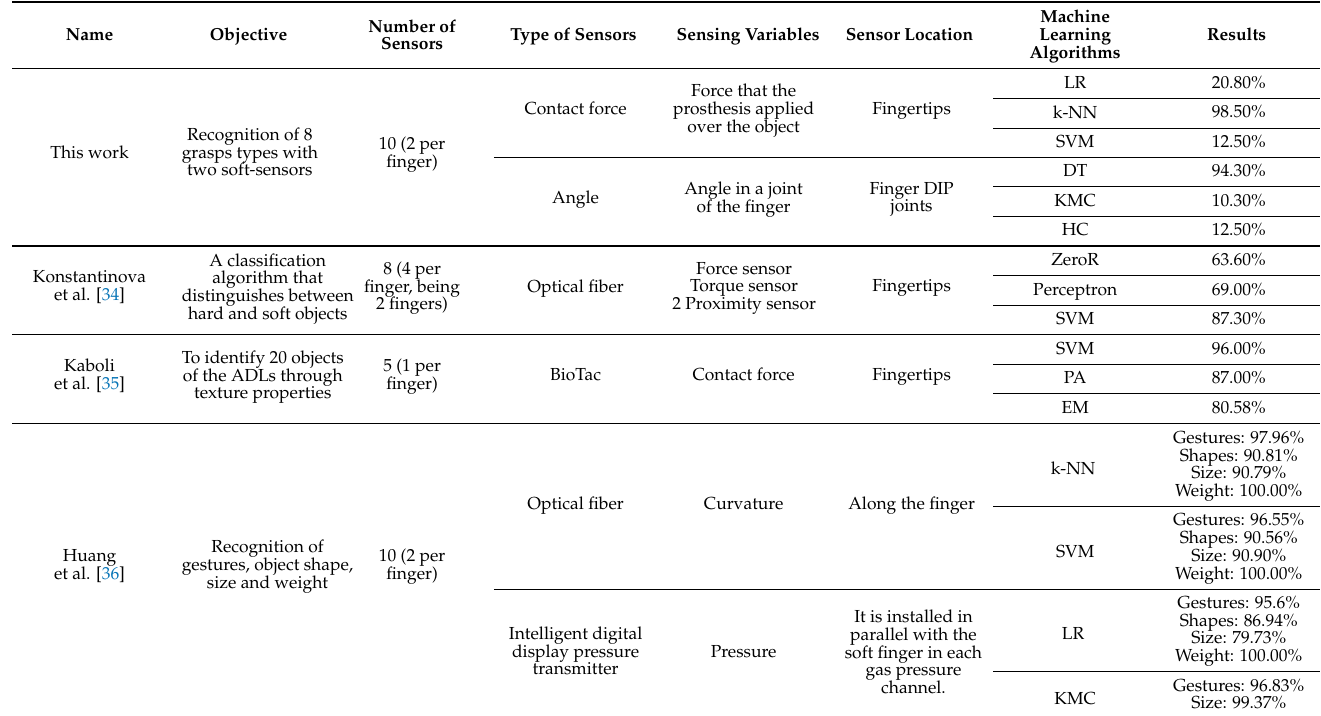
Table 6. Comparison of the results obtained in this study concerning the